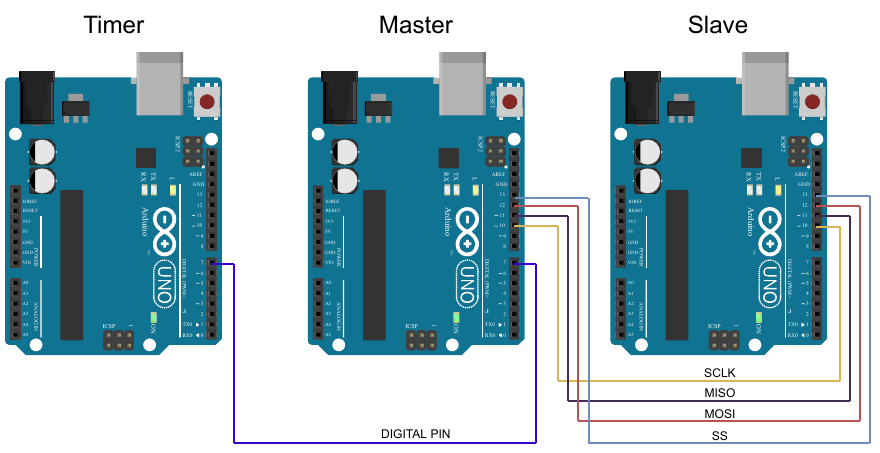
Figure 9. Arrangement of how the Arduino Uno boards were